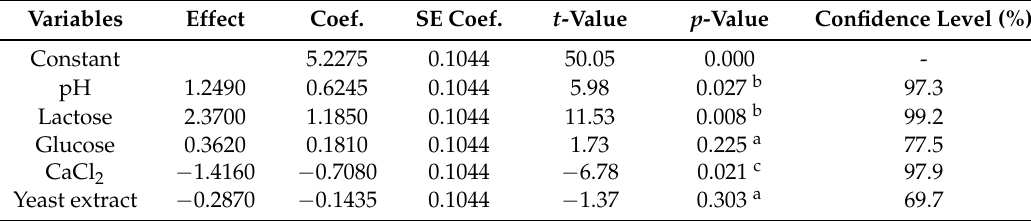
Table 4. Effects of the variables and statistical analysis of the Plackett-Burman design